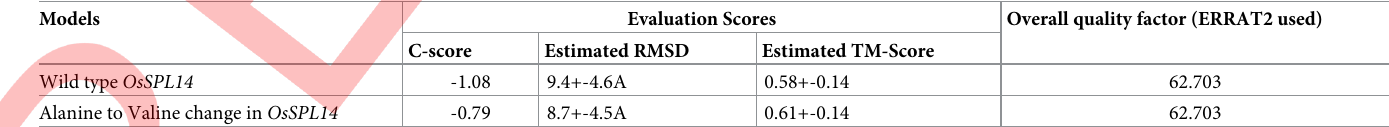
Table 5. Protein model score of the predicted wild and alanine to valine substitution.